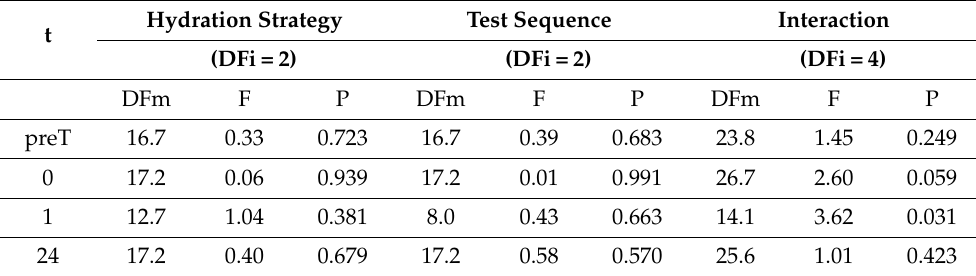
Table 6. Results of analysis of variance for pro-oxidant/antioxidant status and oxidative status measured before the test (preT) and 0, 1, and 24 h after the exercise test: significance of (P) and F-statistic along with the number of degrees of freedom (DFi—in the numerator; DFm—in the denominator) for the fixed effects (hydration strategy, test sequence, and their interaction).